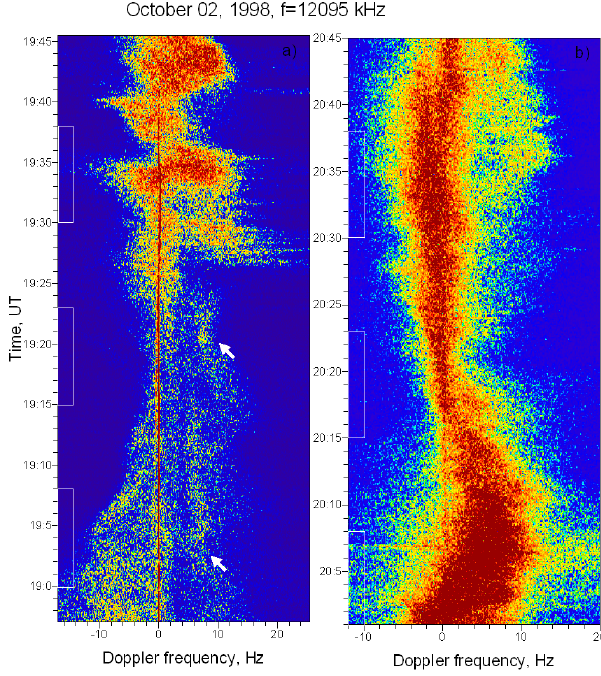
Figure 4 . Dynamic Doppler spectra of HF diagnostic signals on the London–Tromsø–St. Fig. 4. Dynamic Doppler spectra of HF diagnostic signals on the Petersburg path on 2 October 1998, at the frequency 12,095 kHz: (a) 18.57–19.46 UT; (b) 20.01–20.45 UT. The direct signals propagating from the transmitter to the receiver along quency 12,095kHz: ( a ) 18:57–19:46 UT; ( b ) 20:01–20:45 UT. The a great circle path correspond to zero Doppler shifts. The intervals when the Tromsø HF direct signals propagating from the transmitter to the receiver along heating facility was turned on are marked by bars on the time axis. Arrows on the Doppler a great circle path correspond to zero Doppler shifts. The inter- sonogram correspond to the signals scattered from the heater-enhanced natural field-aligned vals when the Tromsø HF heating facility was turned on are marked irregularities. by bars on the time axis. Arrows on the Doppler sonogram cor- respond to the signals scattered from the heater-enhanced natural field-aligned